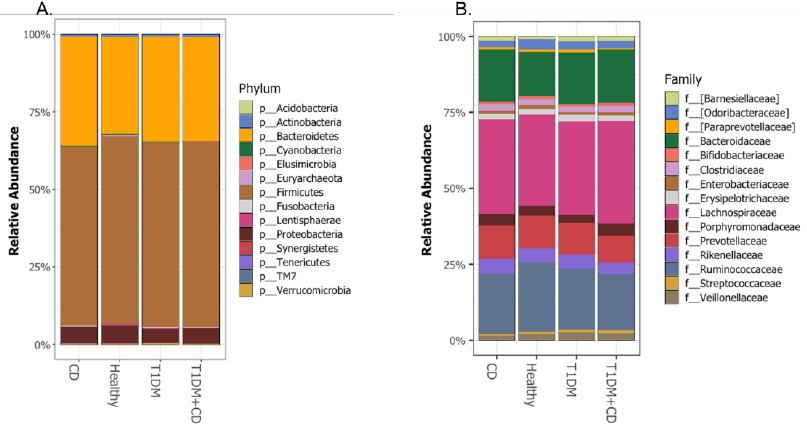
Figure 4. Comparison of the relative abundance at the ( A. ) Phylum ( B. ) Family levels among the different groups included. Abbreviations: T1DM = Type 1 Diabetes; CD = Coeliac disease; p = phylum; f = family.